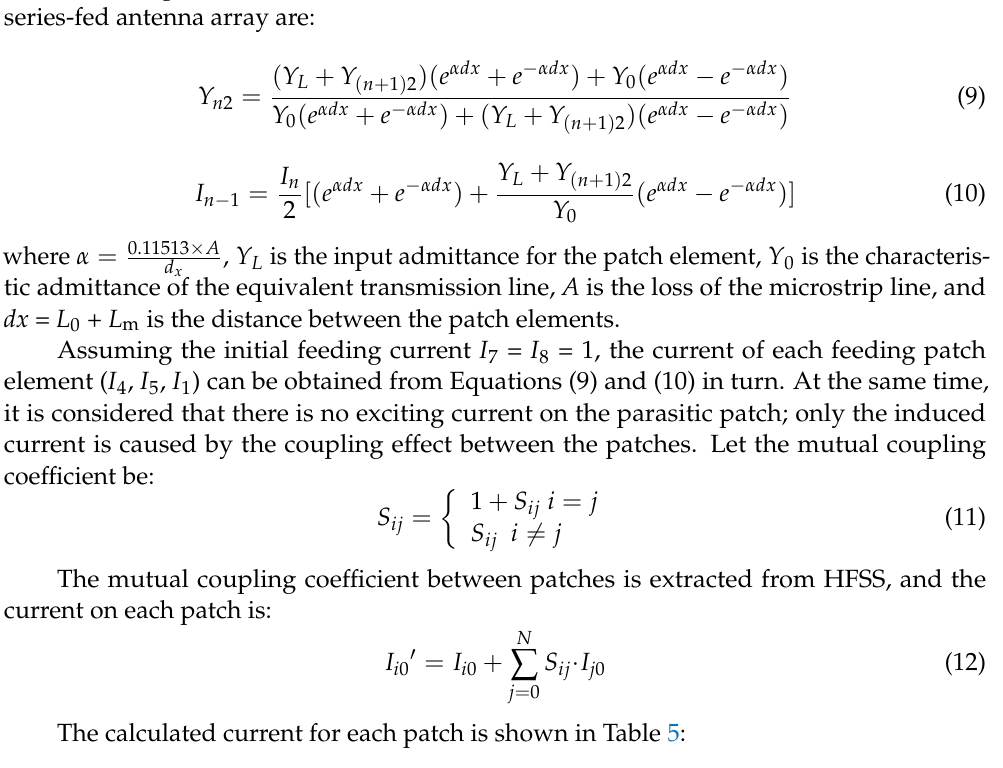
Table 5. Excitation current of the patch